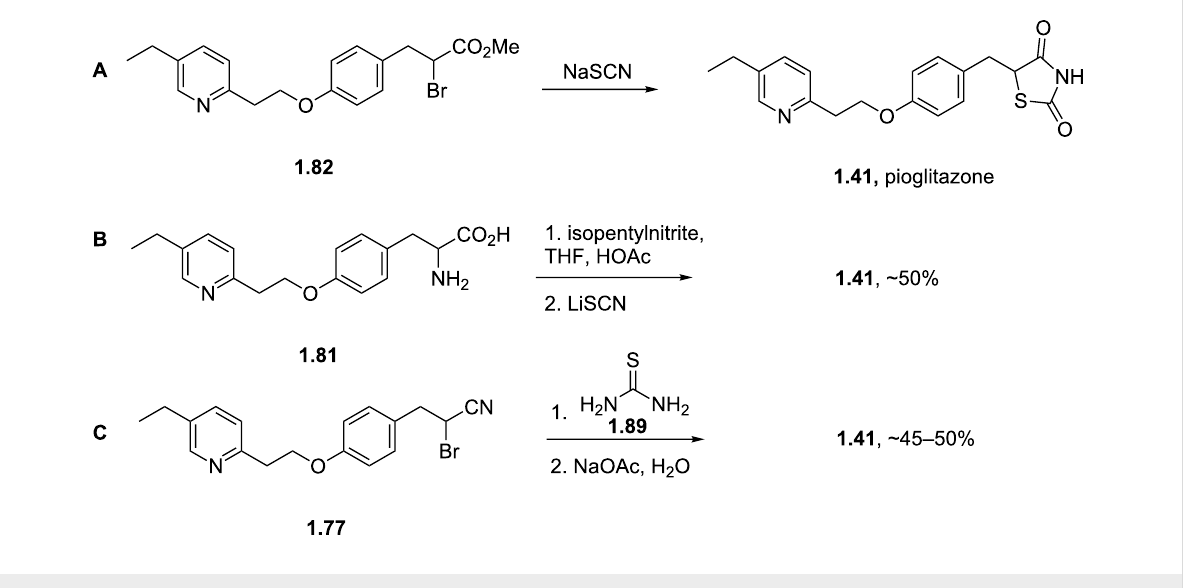
Scheme 16: Syntheses of the thiazolidinedione